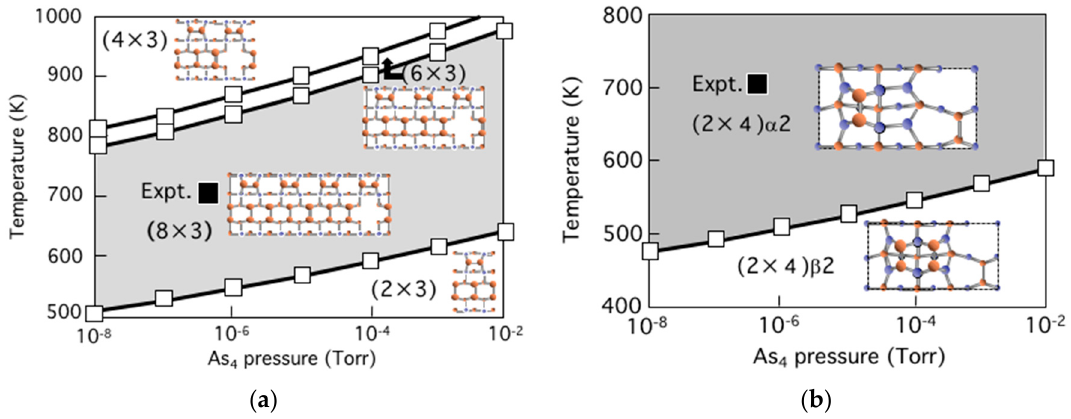
Figure 8. Calculated surface phase diagrams for InAs(001) WL surfaces such as ( a ) (2 × 3) and ( b ) (2 × 4) as functions of temperature and BEP of As 4 . Black square denotes the t conventional MBE growth conditions.